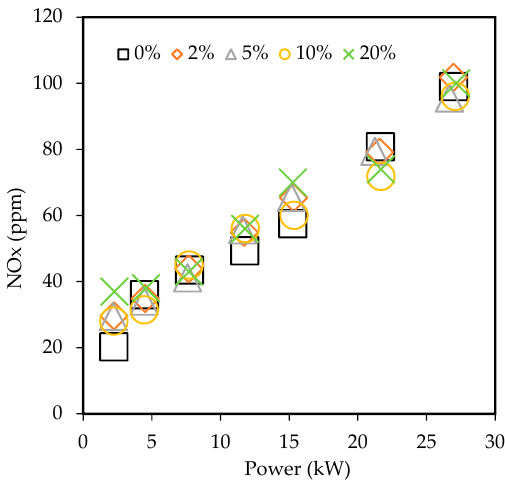
Figure 11. Variations in NOx emissions of tested fuel types.